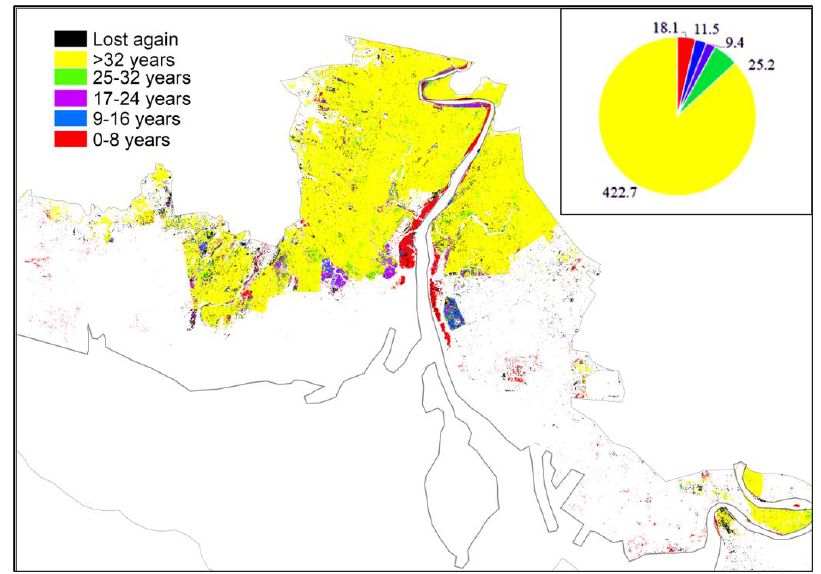
Reeds increased from 462.2 km 2 in 1986 to 486.9 km 2 by 2018. The area of reeds that